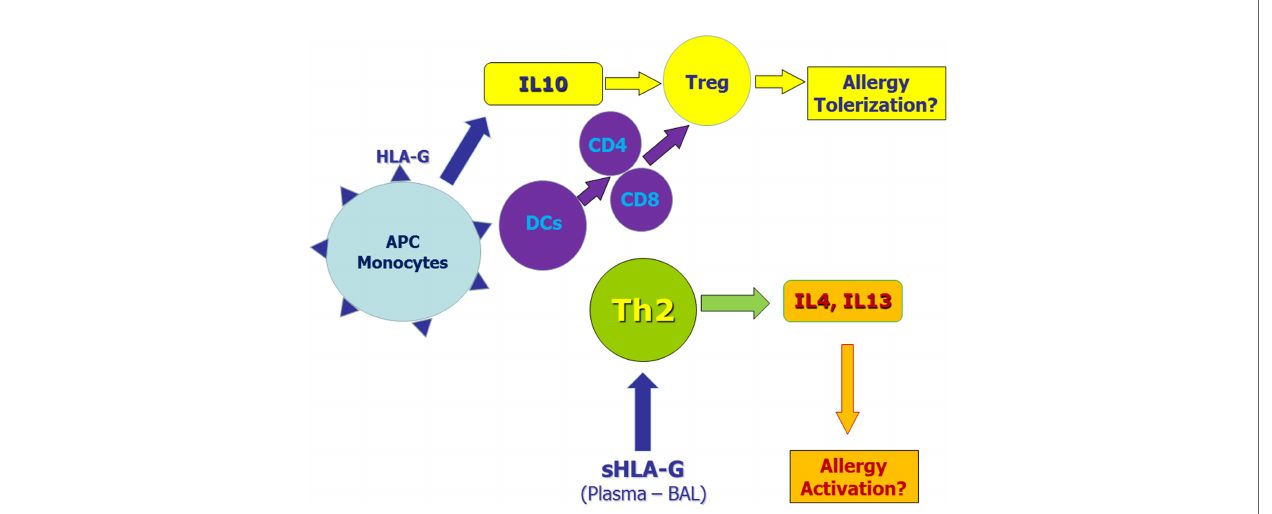
FIGURE 1 | Potential role of membrane-bound and soluble HLA-G molecules in allergic diseases. Monocytes and antigen presenting cells (APC) expressing membrane-bound HLA-G molecules secrete IL-10 and induce tolerogenic dendritic cells. These mechanisms induce regulatory T cells (Tregs) that may exert tolerogenic effects on the allergic process. On the other hand, soluble HLA-G molecules in plasma and/or bronchoalveolar lavage (BAL) may facilitate Th2 polarization thus sustaining allergic